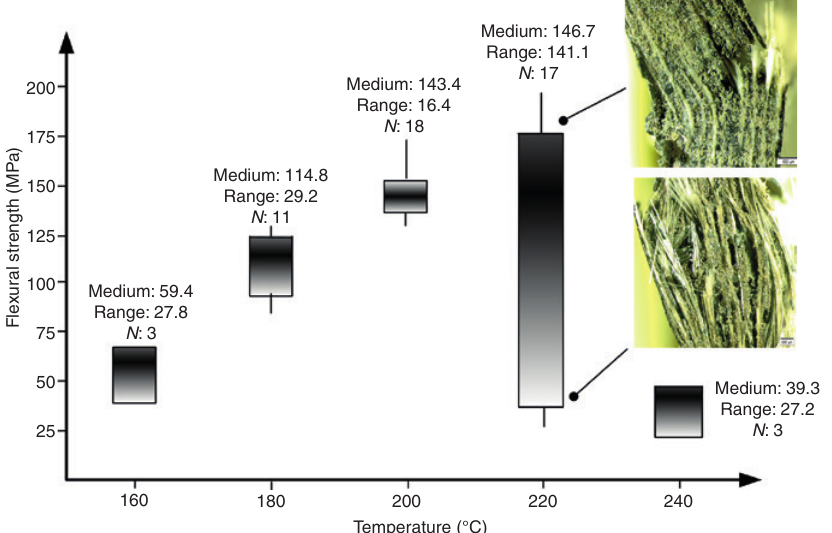
Figure 5: The effect of processing temperature on the flexural strength of the samples ( N indicates the number of measurements, and range denotes results variation), the 200 ° C produced samples have the least dependency on the other parameters.